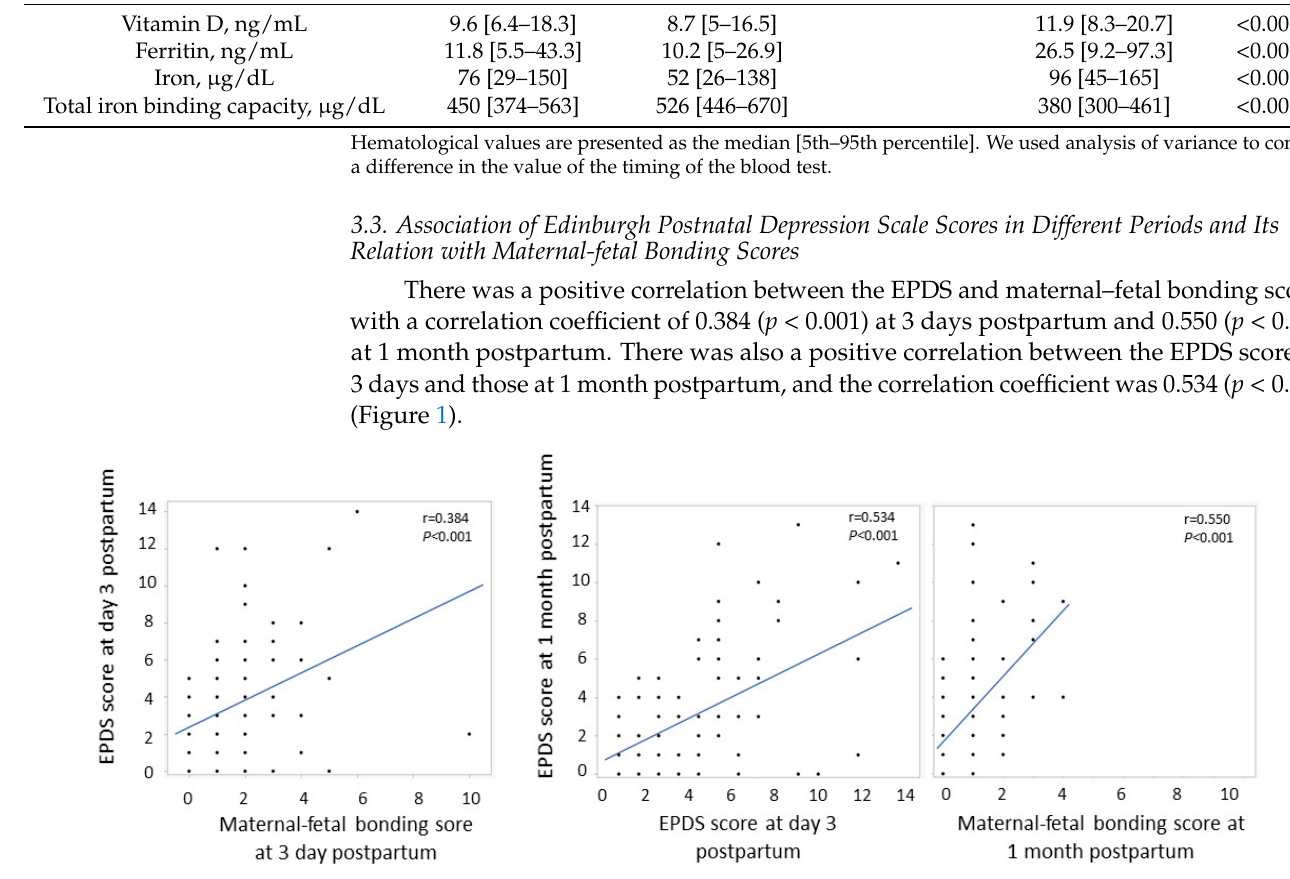
Figure 1. Association of Edinburgh Postnatal Depression Scale scores in different periods and its relationship with maternal-fetal bonding scores.